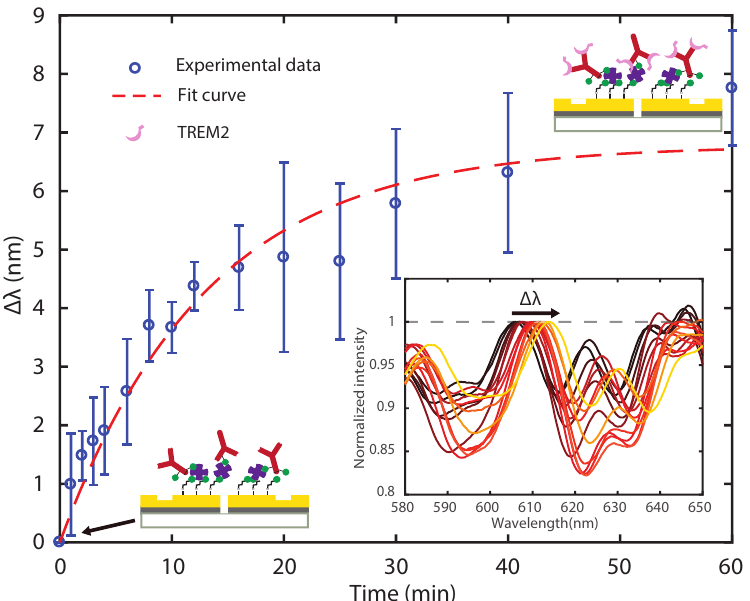
Figure 5. Sensing temporal evolution of TREM2 surface binding kinetics with plasmonic inter- ferometry. Blue circles represent the mean peak shift ( ∆ λ ) averaged over seven nominally identical GSG plasmonic interferometers as the result of temporal evolution of antigen-antibody binding reaction for a 2.7 ng/ml TREM2 0.5% BSA PBS. Error bars represent the standard deviation. Bottom right inset illustrates the normalized transmitted spectra (averaged over seven identical GSG interfer- ometers) measured at each time step. Color changing from dark red to yellow represents increasing reaction time from 0 to 60